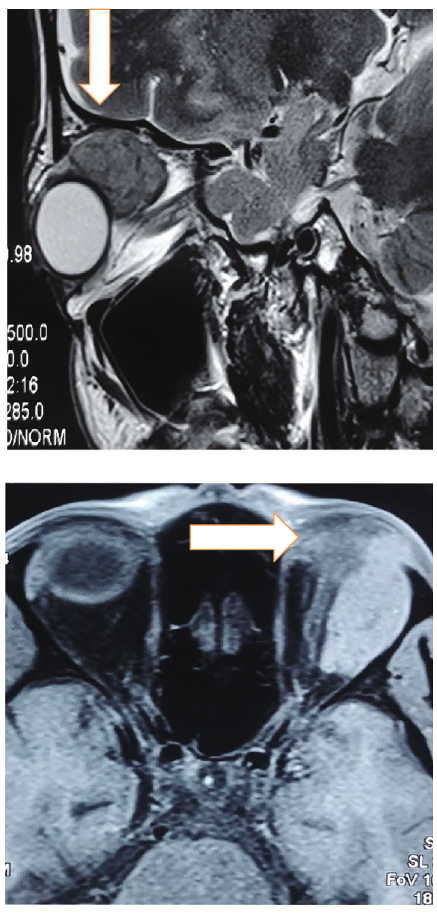
Figure 2: CE-MRI (Contrast-Enhanced Magnetic Resonance Imaging) showing left well-de fi ned orbital lesion in the extraconal compartment abutting the left lateral rectus muscle with intraconal extension.